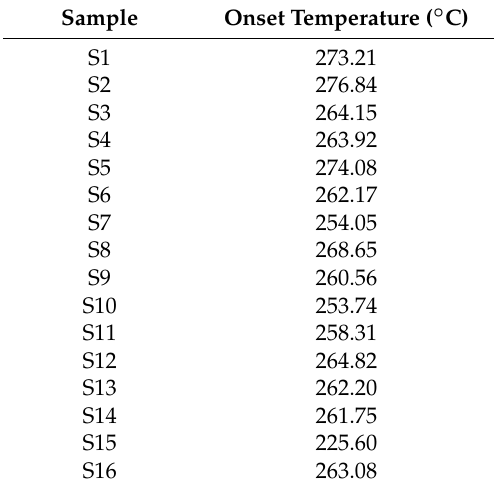
Table 5. Onset temperatures of PUs